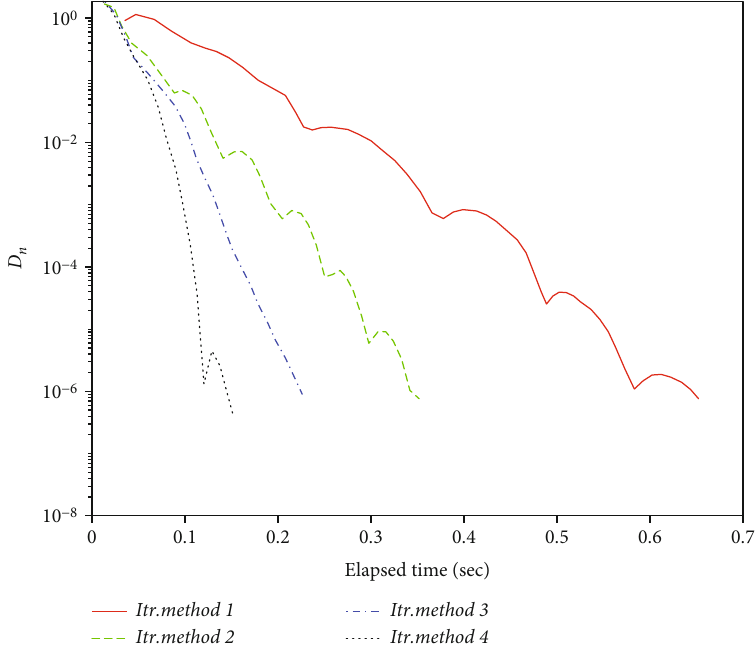
Figure 4: All methods are compared computationally while x